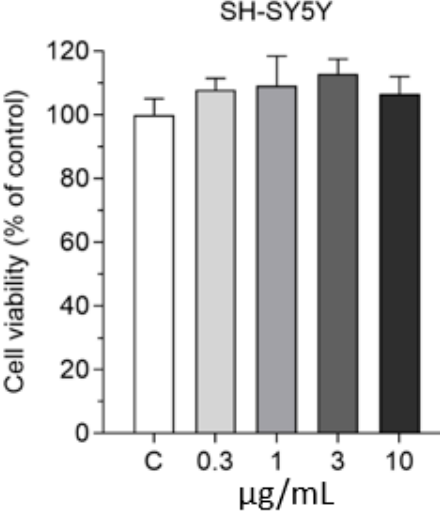
Figure 6. Effect of non-targeted SLNs (DON-SLN) on the viability of differentiated SH-SY5Y human neuronal cells measured by MTT test. Values presented are means ± SEM and are given as a percentage of control. Statistical analysis: one-way ANOVA followed by Dunnett’s posttest; n = 6–8. C: culture medium-treated control group.